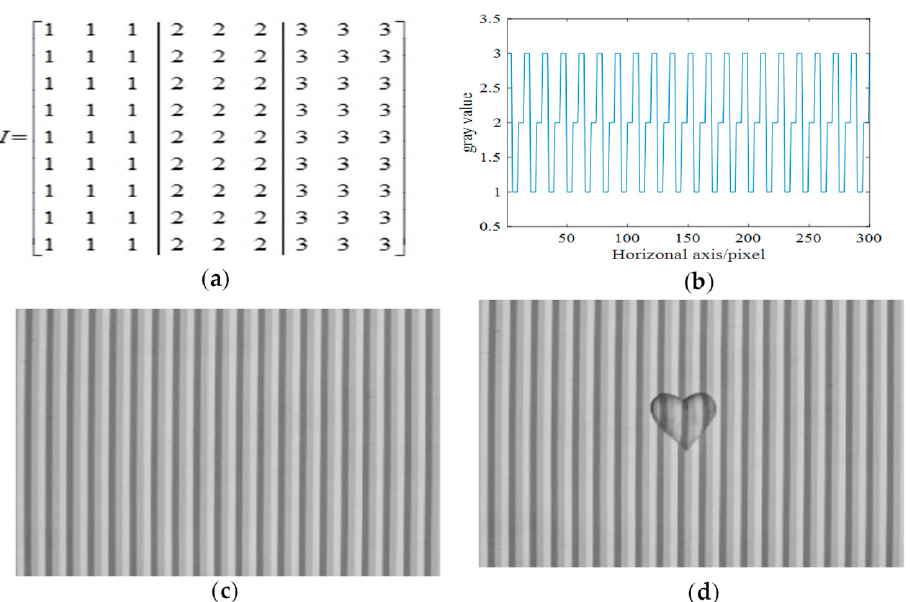
Figure 4. Quaternary grating encoding and capturing: ( a ) coding matrix; ( b ) the cutaway view of quaternary grating; ( c ) captured fringe pattern; and ( d ) captured deformed pattern.